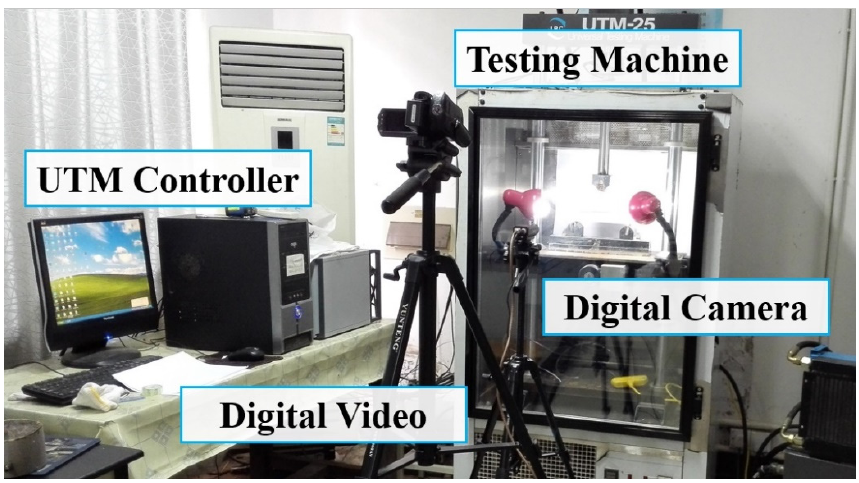
Figure 4. Universal test machine (UTM) loading cooperated with digital image correlation (DIC).